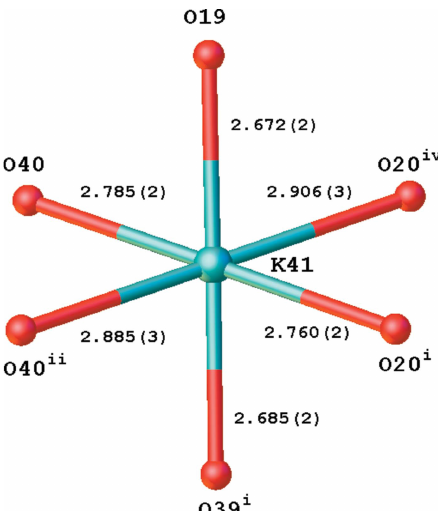
Figure 2 Overlay diagram of the two molecules A (green) and B (blue), comprising the asymmetric unit. H atoms are hidden for clarity ( Mercury ; Macrae et al. , 2020).